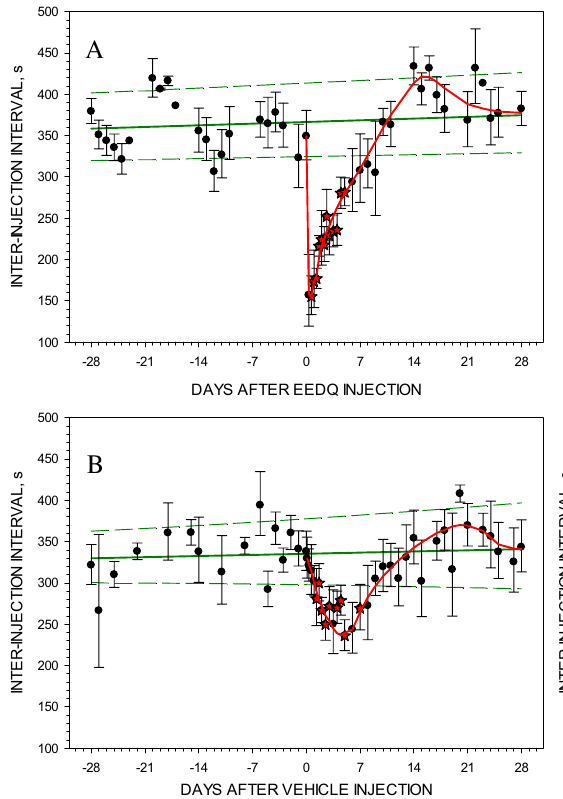
Figure 4. Effect of EEDQ (Panel A ) or a vehicle (Panel B ) injection on inter-injection intervals at a cocaine unit dose of 3.0 μmol/kg. EEDQ was injected 24 or 32 days after vehicle injection. Solid straight lines (green) represent linear regression of geometric means ± 95% confidence intervals of inter-injection baseline intervals from 7 rats. Each data point represents the mean ± SEM from 7 rats. Solid curved lines (red) represent the best approximation to the vehicle/frequent access effect and to EEDQ effect drawn based on visual analysis.